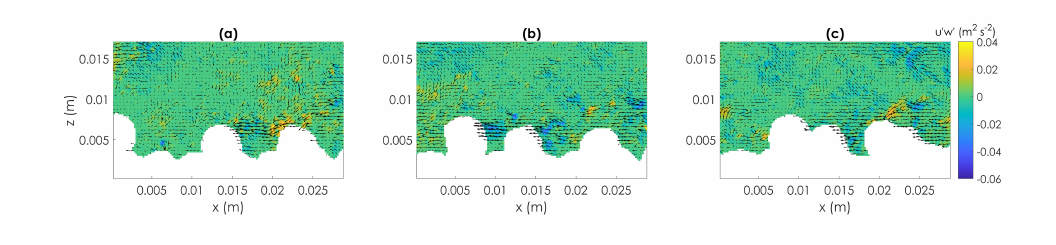
Figure 24. Instantaneous Reynolds shear stress maps with vectors superimposed representing velocity fluctuations obtained for disentrainment event number 3-Test T1 for the sequence of three PIV images reported in Figure 23. (For clarity only 1 out of 2 vectors are depicted.) ( a ) The moving particle enters the FoV. ( b ) As it aproaches a cluster of particles the instantaneous Reynolds shear stresse are significantly higher, as seen by the blue area close to the cluster. Ejection events are observed. ( c ) The moving particle stops due to the